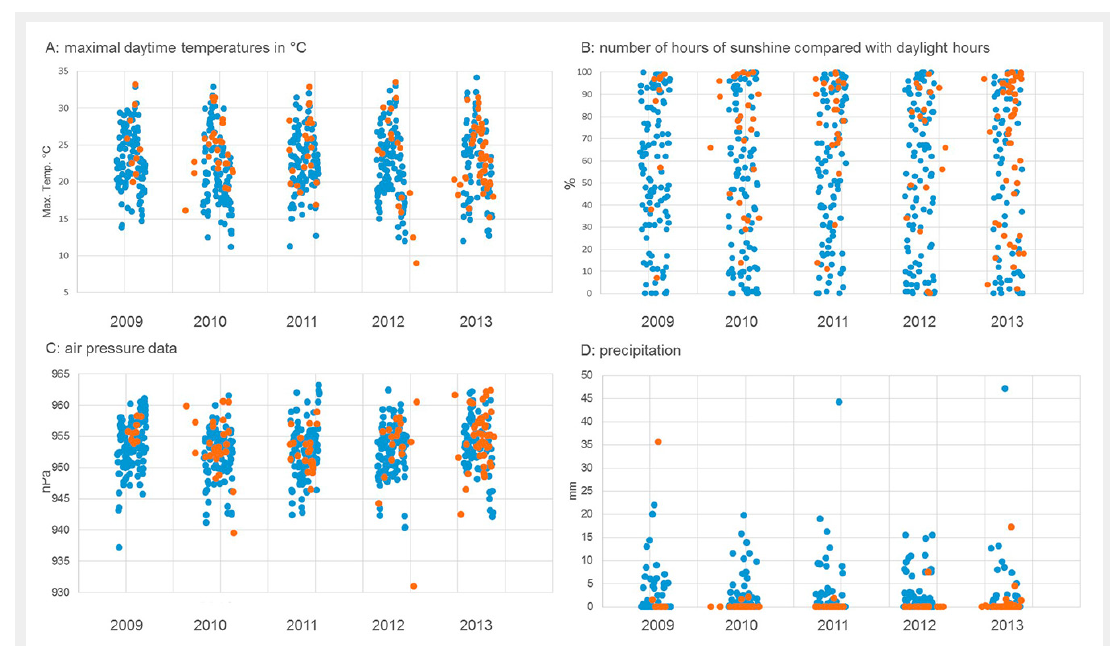
Figure 6 Meteorological data. Each dot represents a day without recorded hymenoptera sting (blue) or a day with a hymenoptera sting (orange). Maximal temperatures are shown in A, numbers of sunshine compared with daylight hours in B, air pressure data in C and precipitation in